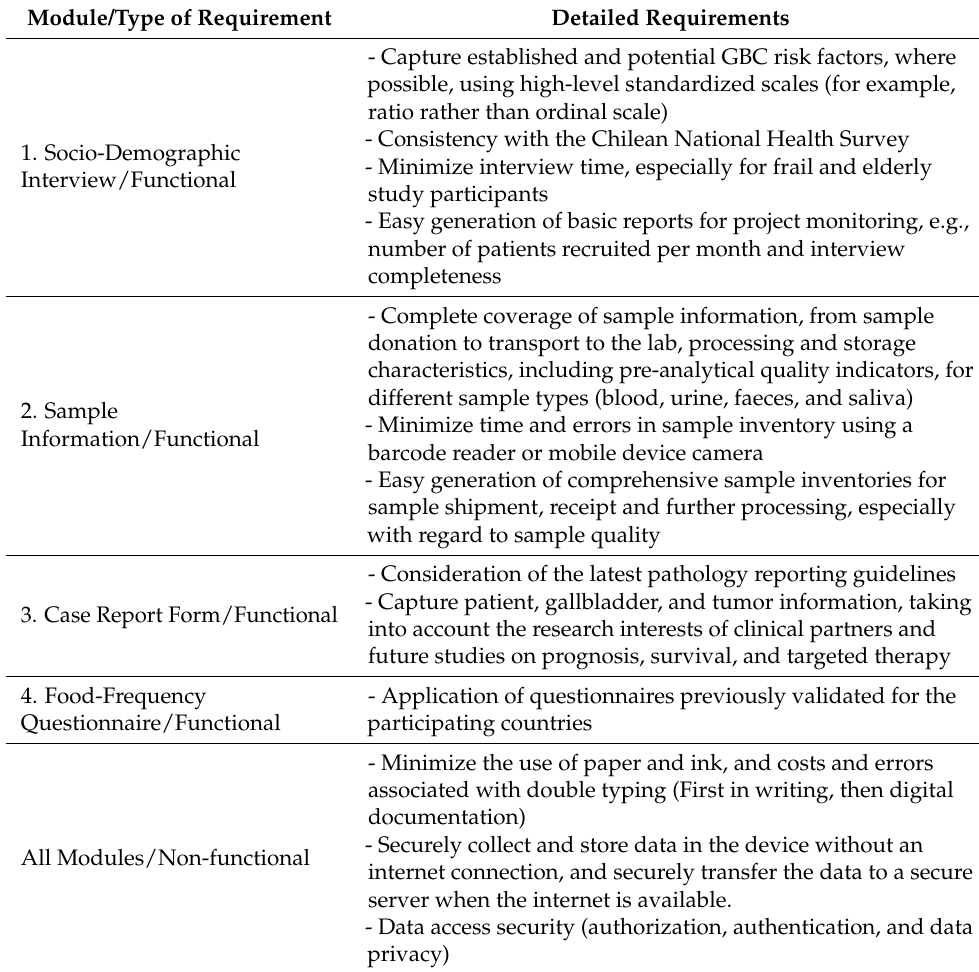
Table 1. Summary of the application requirements as outcome of the inspection of EULAT Eradicate GBC documents, complemented by extensive discussions of the whole development